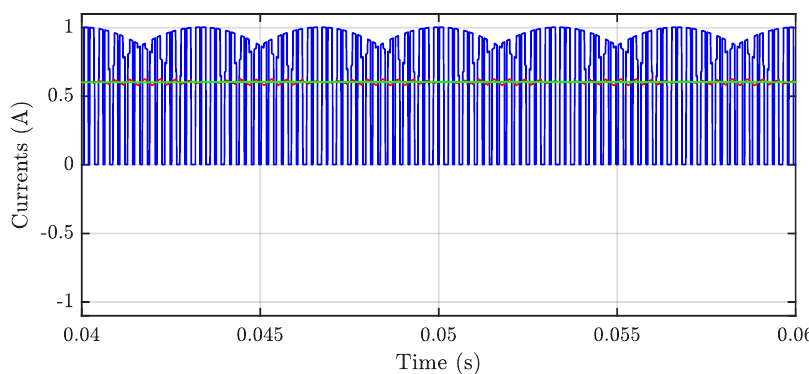
Figure 2. Instantaneous input current: (blue), its averaged value over the switching period (red), and calculated value (green) in case of balanced output currents for m = 0.4, I = 1A and ϕ = 0° .